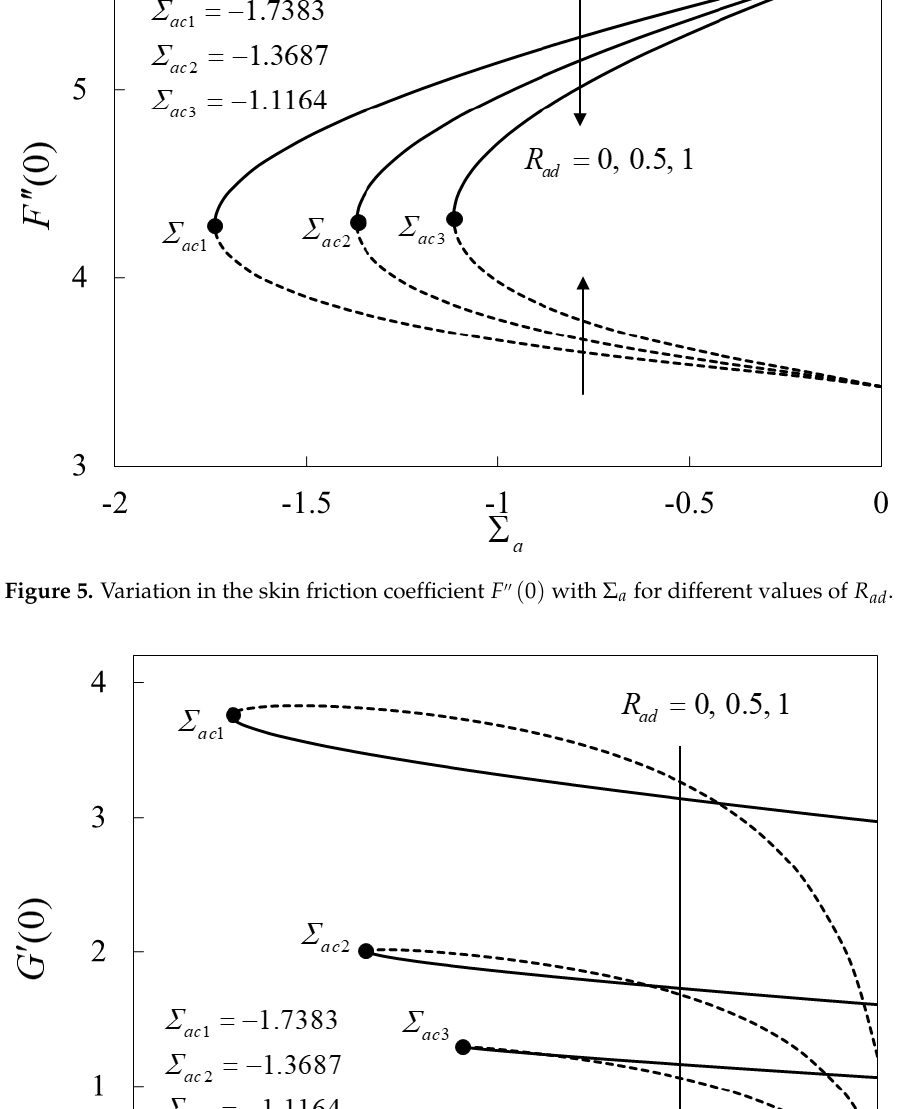
Figure 7. Variation in the local Sherwood number   ' 0 S with  a for different values of ad R . Figure 8 expounds the variations in the thermophoretic parameter  a on the local Sherwood number r x Sh of the (Ag-TiO 2 /water) hybrid nanoparticles for both solution branches versus  a . For rising values of  a , the mass transfer rate enriches for the FBS as well as for the SBS, while the gap between the outcomes looks similar in both branches with  a . Generally, this behavior is due to the fact that higher consequences of the pa- rameter  a can improve the thermophoretic coefficient k ; as a result, the mass transfer